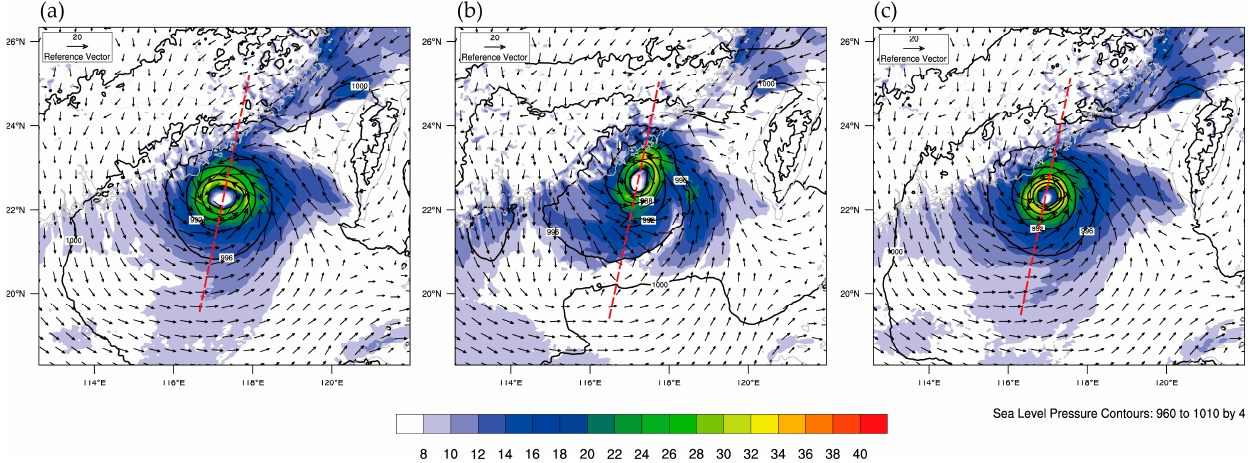
Figure 8. Sea-level pressure field (black contour), 10-m wind speed (shaded, unit: m s − 1 ) and wind vector (arrow, reference vector = 20 m s − 1 ) of the ( a ) CTRL, ( b ) DA_len1.0 and ( c ) DA_len0.25 experiments at 0000 UTC on 9 July 2015.